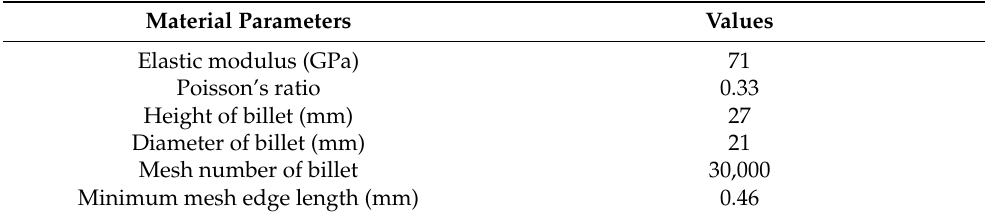
Table 2. The specific parameters of 7075 Al alloy billet used in the